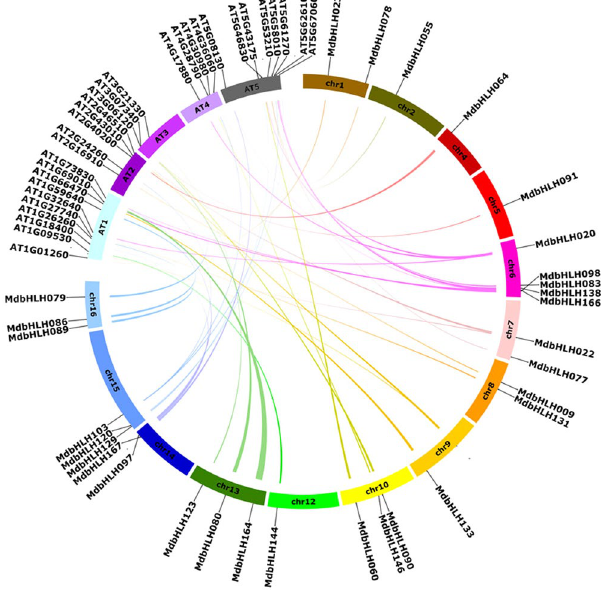
Figure 5. Synteny analysis of bHLH genes between apple and Arabidopsis. Apple and Arabidopsis bHLH genes are indicated by vertical black lines. Colored bars denote syntenic regions between apple and Arabidopsis bHLH genes. Chr, chromosomes.